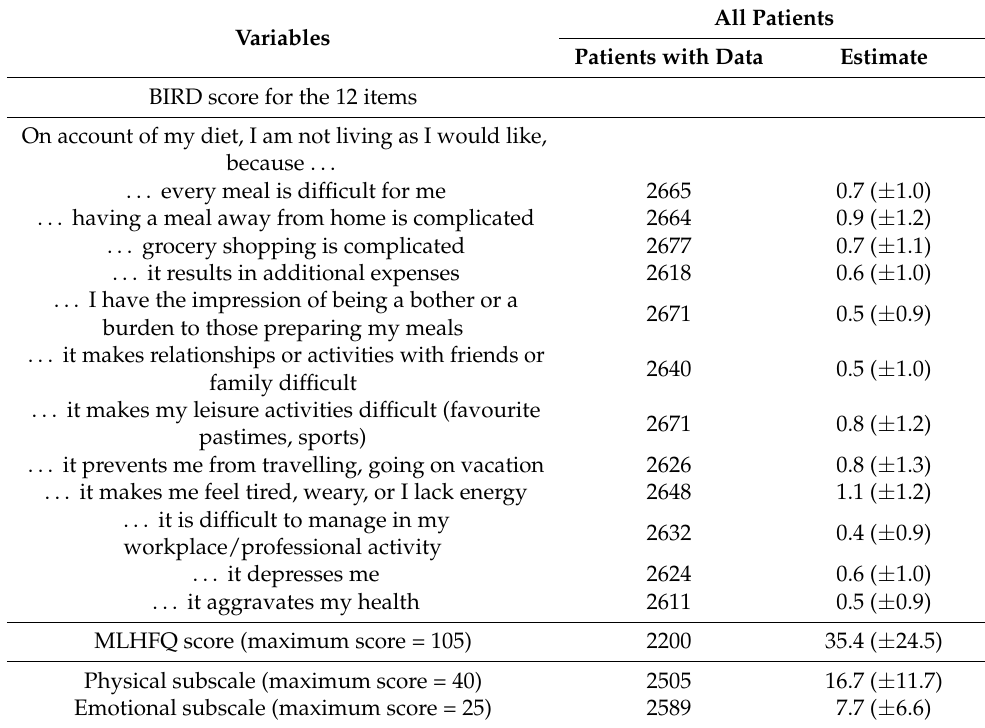
All Patients Patients with Data Estimate